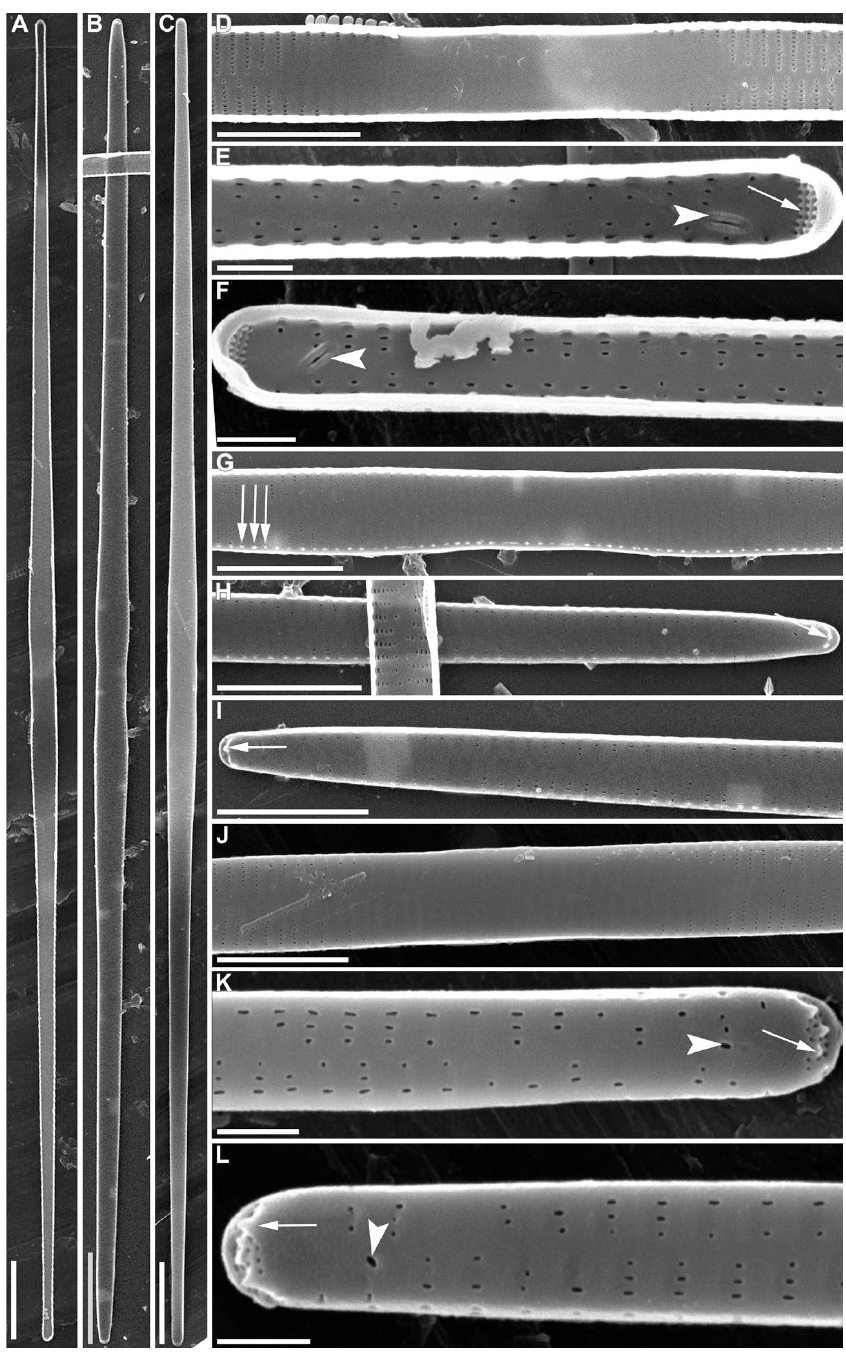
Figure 5. Valve structure of strains Fra group, strains MM101 ( A , D – F , C , J – L ) and MM113 ( B , G – I ). SEM. Three complete valves: ( A ) inside view; ( B ) valve with margin spines, outside view; ( C ) valve without margin spines, outside view; ( D ) central area detail of ( A ); ( E , F ) apex detail of ( A ) (arrow—ocellulimbus; arrowhead—rimoportula); ( G ) central area detail of ( B ) (arrows—marginal spines); ( H , I ) apex detail of ( B ) (arrows—apical spines); ( J ) central area detail of ( C ); ( K , L ) apex detail of ( C ) (arrows—apical spines; arrowheads—holes of rimoportula). Scale bar: ( A – C )—10 µ m; ( D , G – J )—5 µ m; ( E , F , K , L )—1 µ m.